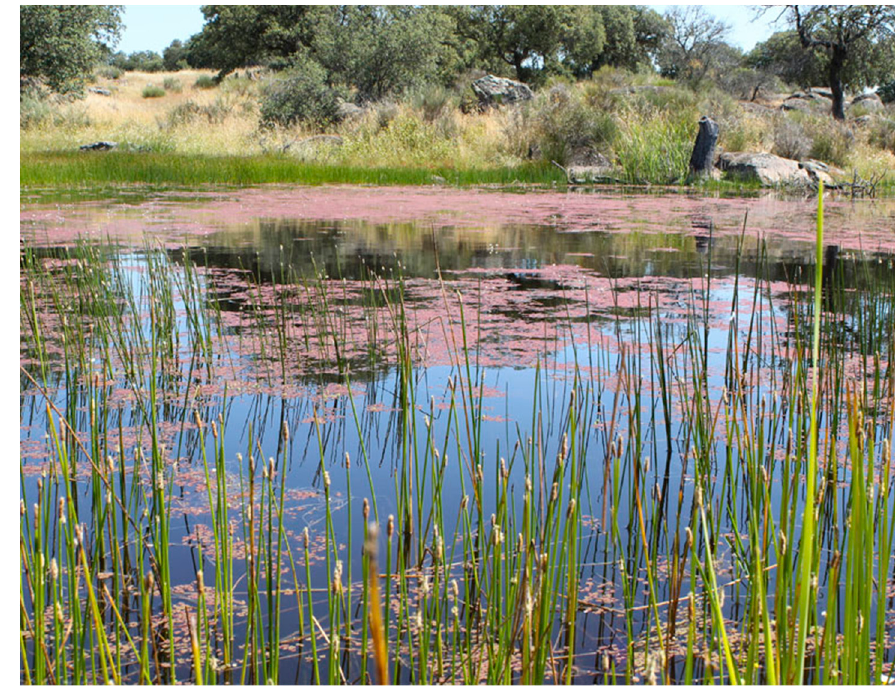
Figure 5. Water surface of one of the watering ponds of the farm in spring. Author: Carmen Perona.